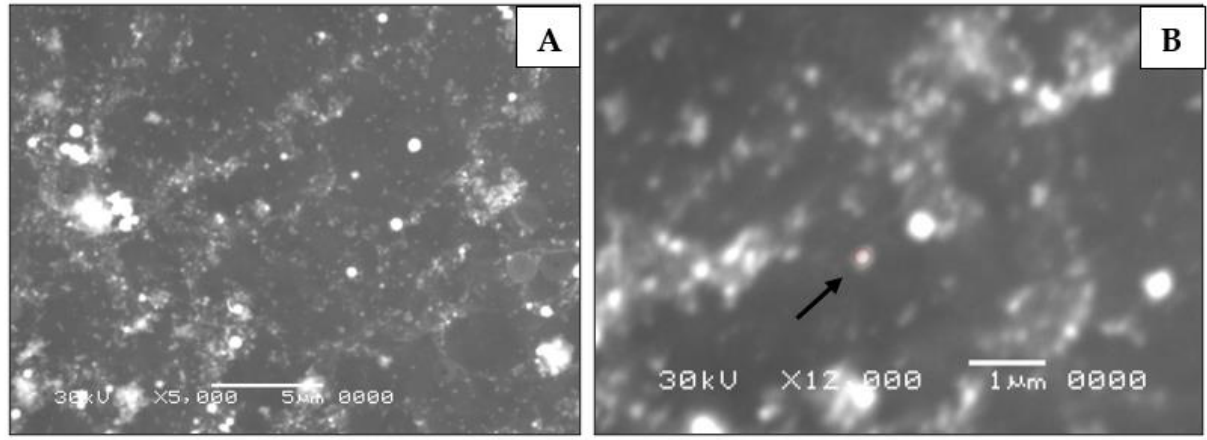
Figure Figure 3. Scanning electron microscopy images of nanoparticles stabilized with the biosurfactant (BS-AgNP): ( A ) 5000× magnification; ( B ) 12,000× magnification.